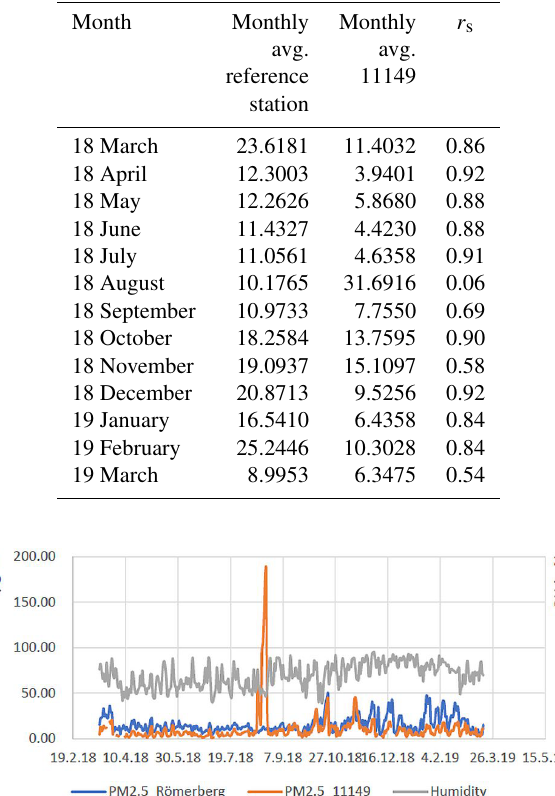
Table 1. Correlation coefficient ( r s ) of the reference station Römer- berg and the sensor 11149.